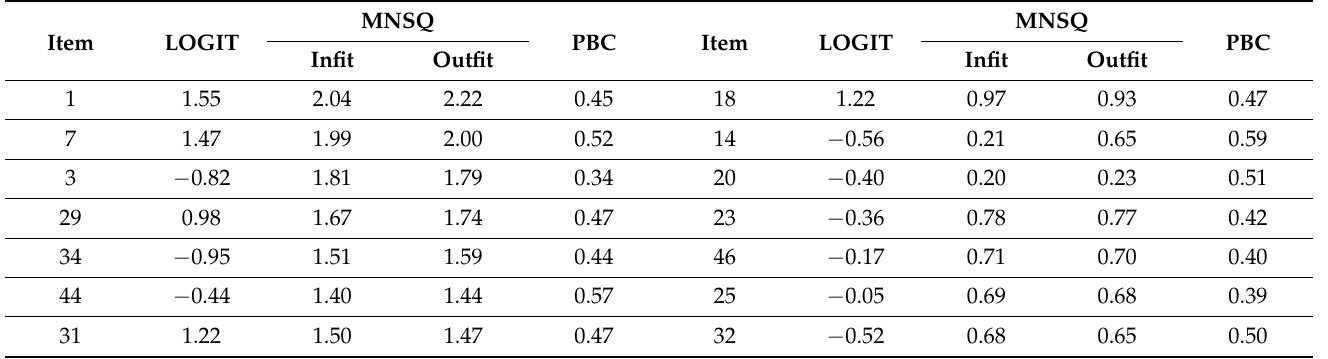
Table 7. Results of item relevance